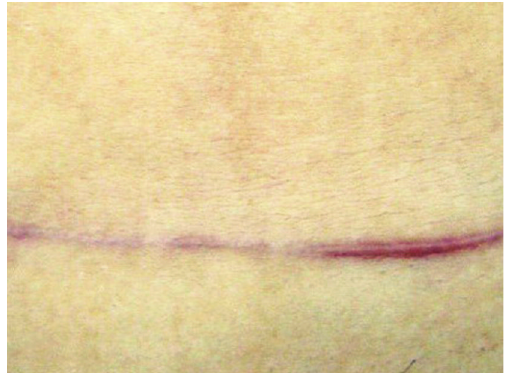
Figure 2: Photograph of a 32-year-old female subject at the 12th week follow-up. Onion extract and placebo were applied on the right and left side, respectively. Hypertrophic scar was visibly more elevated in the left